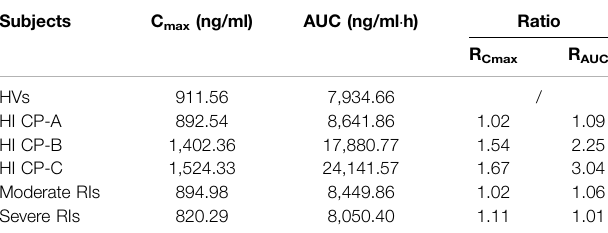
TABLE 6 | Simulated exposure changes of apatinib in patients with HI and RI